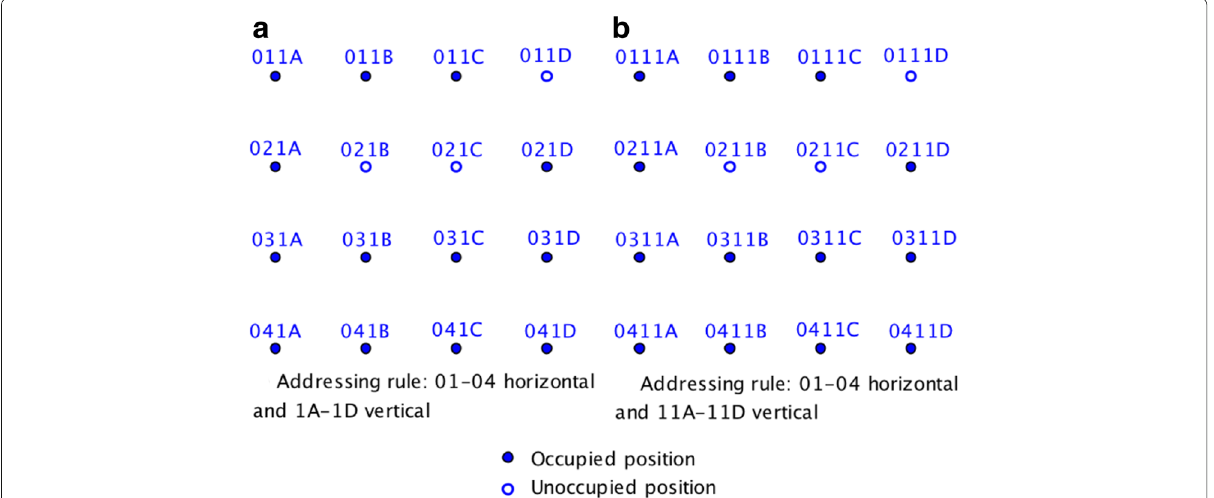
Fig. 2 A 16-node 2-d system with two different addressing schemes. a Addressing rule: 01-04 horizontal and 1A-1D vertical. b Addressing rule: 01-04 horizontal and 11A-11D